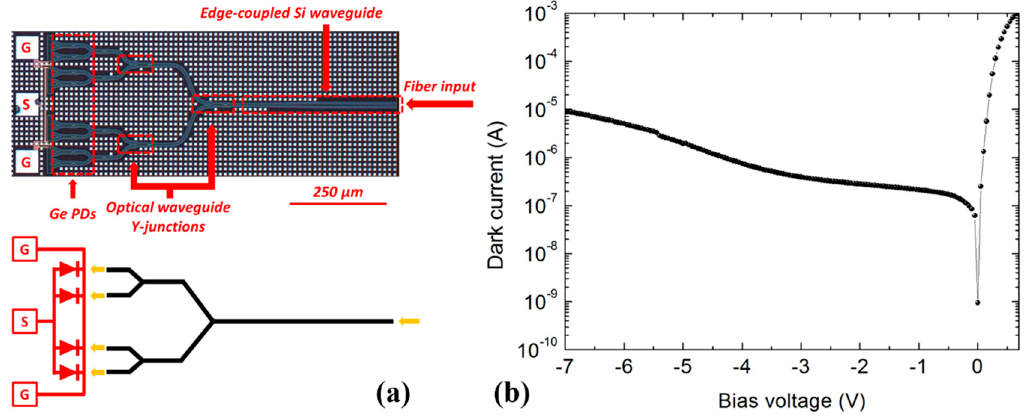
Figure 13. ( a ) Optical image and schematic of the PD array, and ( b ) I-V characteristics.